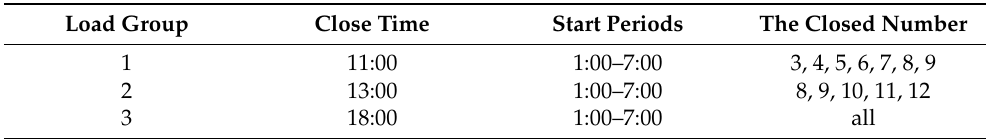
Table 6. Transferring results of disturbed